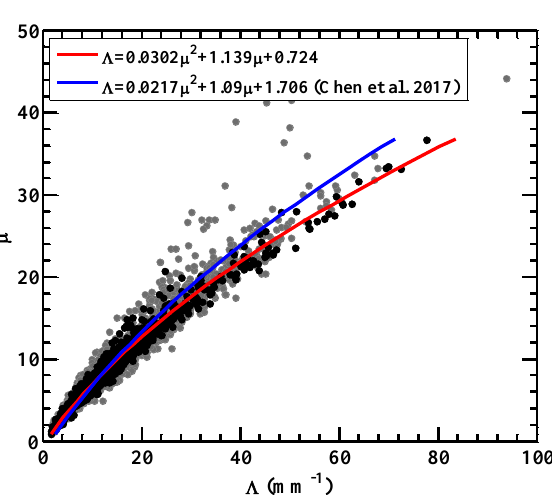
Figure 9. Scatterplots of the gamma parameters of Λ and µ . The gray and black points are from the entire data and the filtered data with drop counts greater than 300, respectively. The red line represents our relationship, the blue line is the relationship for rainfalls in the mid-TP proposed by Chen et al. (2017) [19]. The relationship of µ − Λ for DSDs observed in the mid-TP that were proposed by Chen et al. (2017) is compared (the blue solid line). Our relationship is quite consistent with Chen’s result, but our formula can produce a larger Λ under the same µ